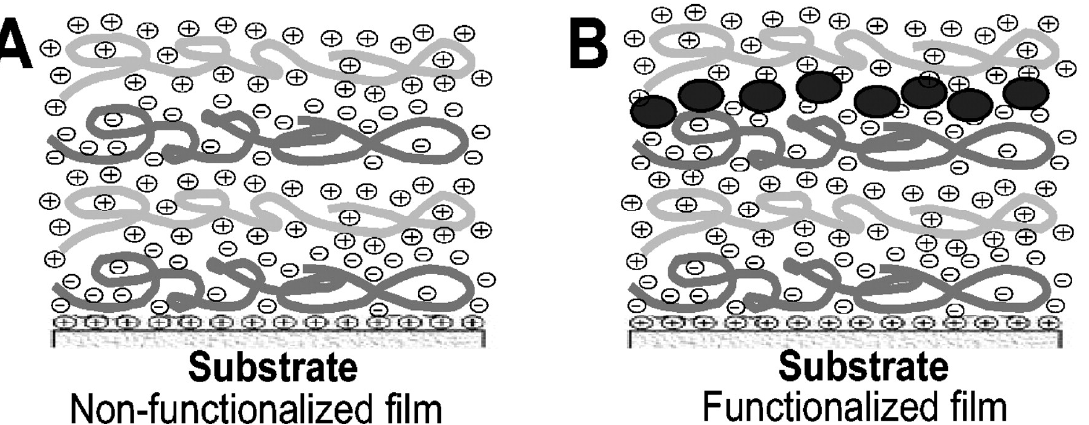
Figure 22. Scheme of polyelectrolyte multilayer film ( A ) and defensin insertion ( B ). Adsorption is obtained by adding a layer of the opposite charge; the peptide is embedded under another polyelectrolyte layer. Reproduced from [86]. Copyright © 2004 American Society for Microbiology.